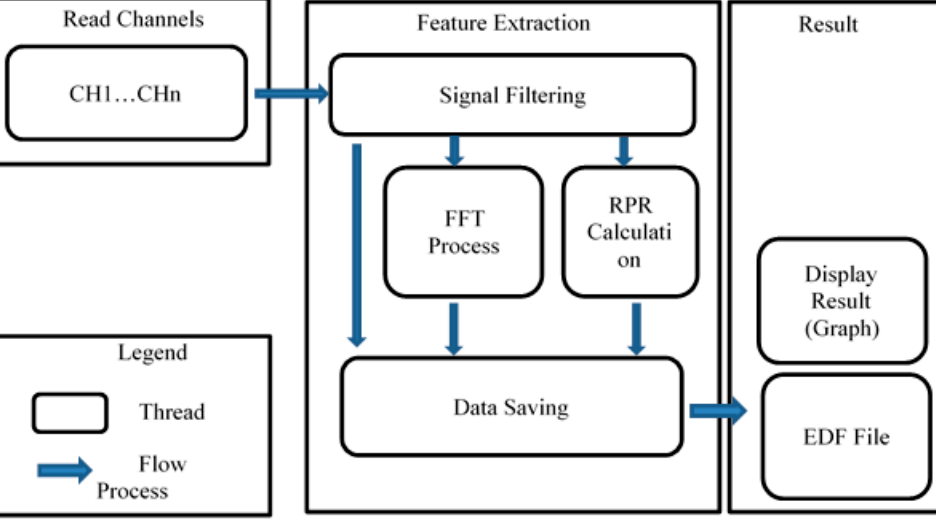
Figure 19. Multithread EEG signal processing description [161].